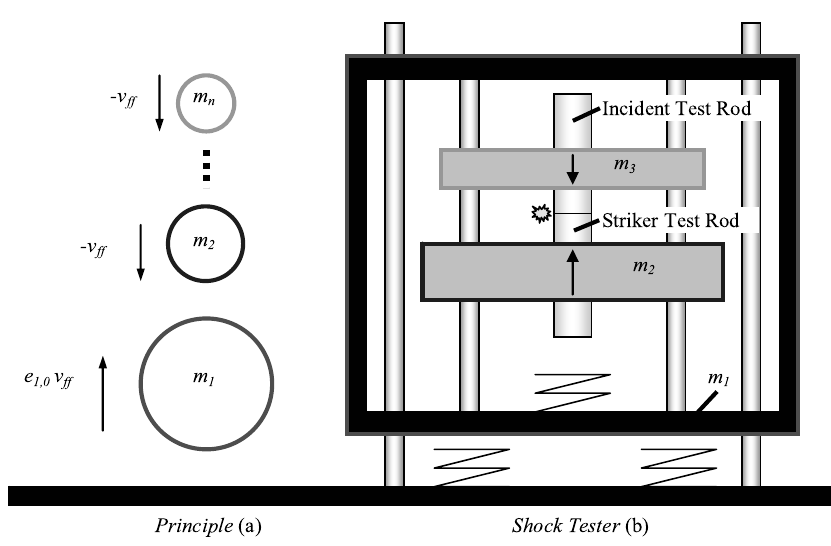
Fig. 1. VAMP principle and a schematic of a VAMP shock tester. denotes impact